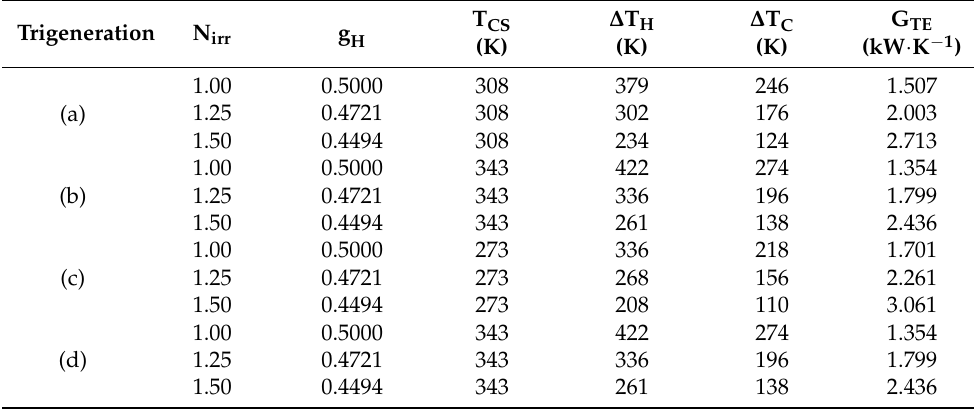
. W E = 100 kW, EE E = 0.35 (imposed), θ HS = 4 (imposed).